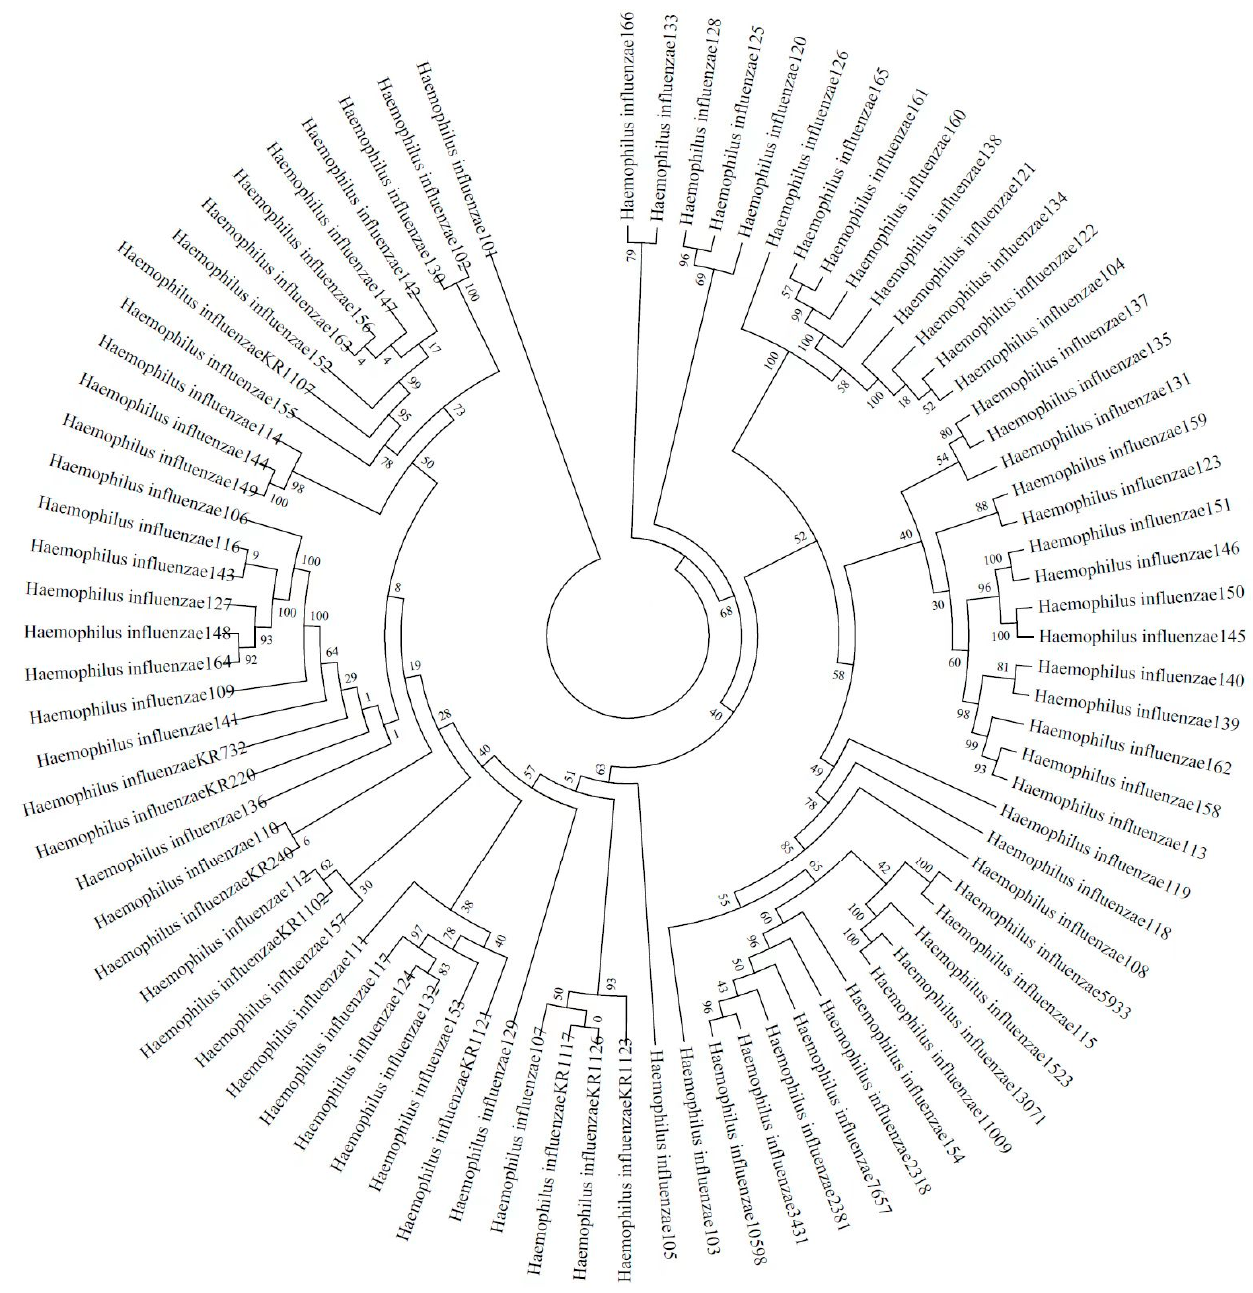
Figure 1. Phylogenetic tree from concatenated sequences of MLST for 66 NTHi isolates isolated from Guangzhou.